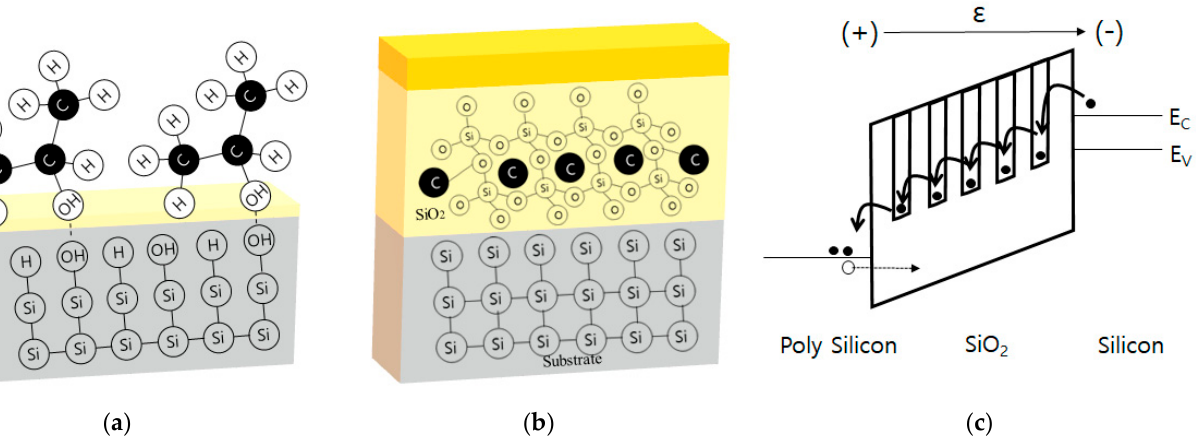
Figure 7. ( a ) Binding of IPA molecules at the OH-terminated interface after IPA drying process. ( b ) Bonding with carbon in Si–O Structure. ( c ) Electron-Hole pair generation (EHP) and hole trapping in SiO 2 caused by carbon particles.